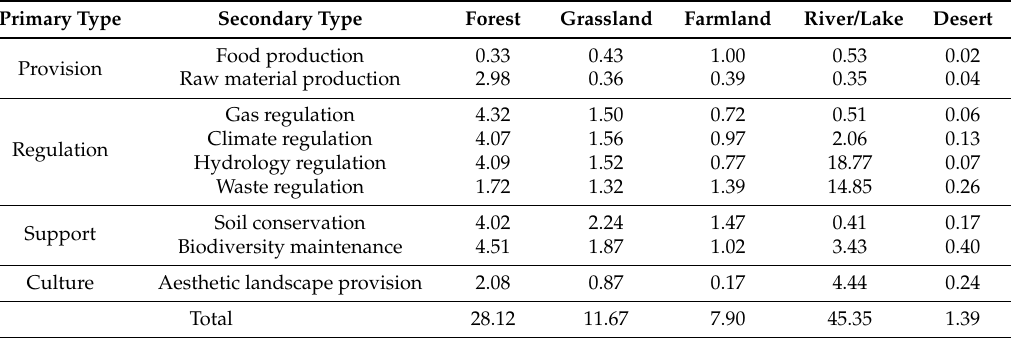
Table 1. Equivalent value per unit area of the ecological service in China. Data source: the study by Xie et al.